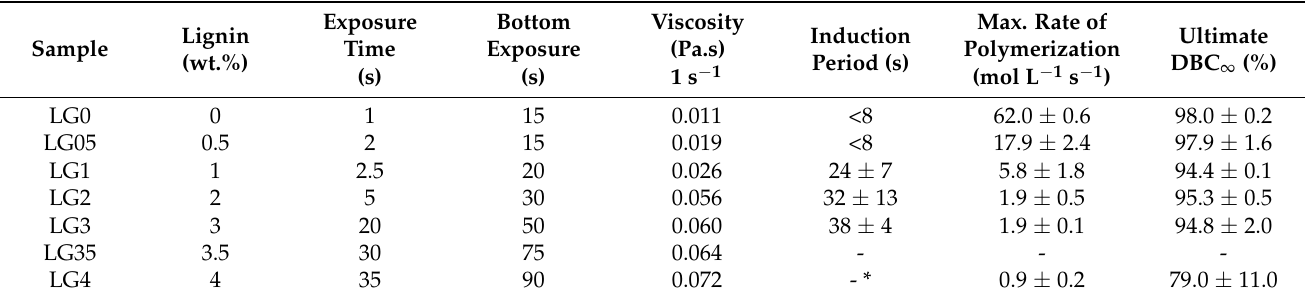
Table 1. Samples formulation, 3D printer exposure times, viscosity at 1 s − 1 , maximum rate of polymerization, and ultimate degree of conversion at 9 mW cm − 2 obtained from Real-Time ATR-FTIR spectroscopy.